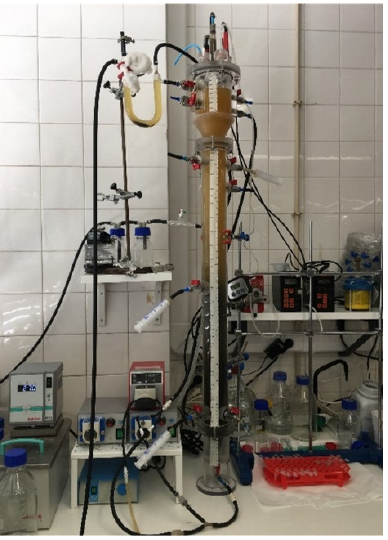
Figure 1. EGSB reactor used for the acidogenic fermentation of hydrolyzed BSG. The reactor was inoculated with anaerobic granules from an EGSB reactor of an industrial Portuguese brewery (Super Bock Bebidas S.A., Matosinhos, Portugal) at 20–30% v / v [14]. The anaerobic reactor was operated in continuous mode at 30.0 ± 0.1 ◦ C and at an HRT of 2.5 ± 0.2 days. The pH was measured online and continuously monitored, but not controlled, during the whole reactor operation. The EGSB was fed with